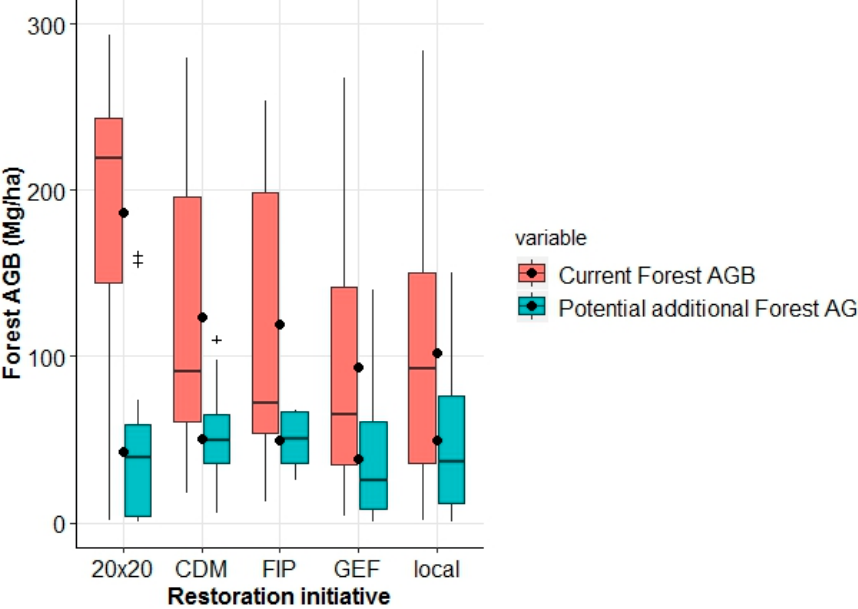
Figure 4. Current forest AGB (Mg / ha), in relation to the potential additional forest AGB, for each type of initiative. Note: the dot represents the mean; the horizontal bar represents the median, the + represents outliers, and the vertical line represents the range in which 95% of the values for all projects per initiative occur.